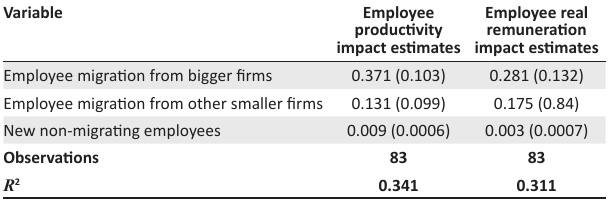
TABLE 1: Panel data estimates for the impact of inbound employee migration on employee productivity and real remuneration without taking employee diversity dimensions into